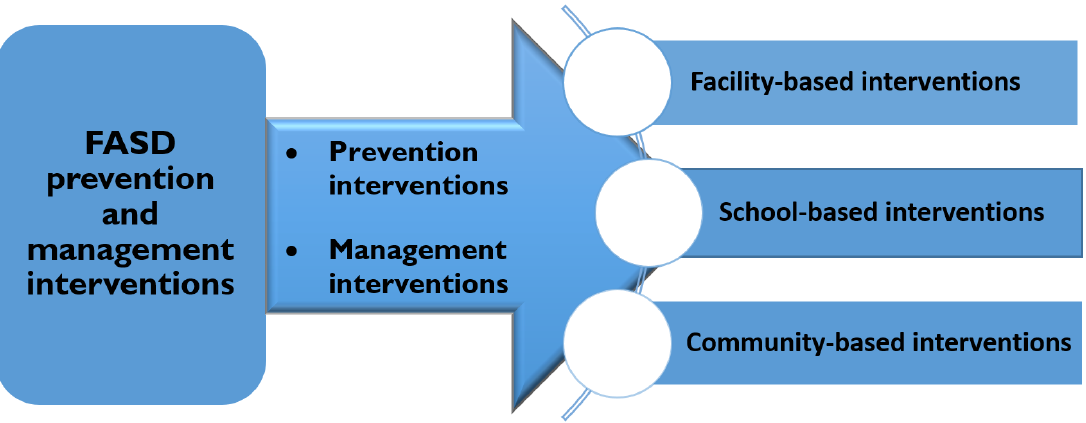
Figure 3. Heuristic classification framework applied to summarize the data.